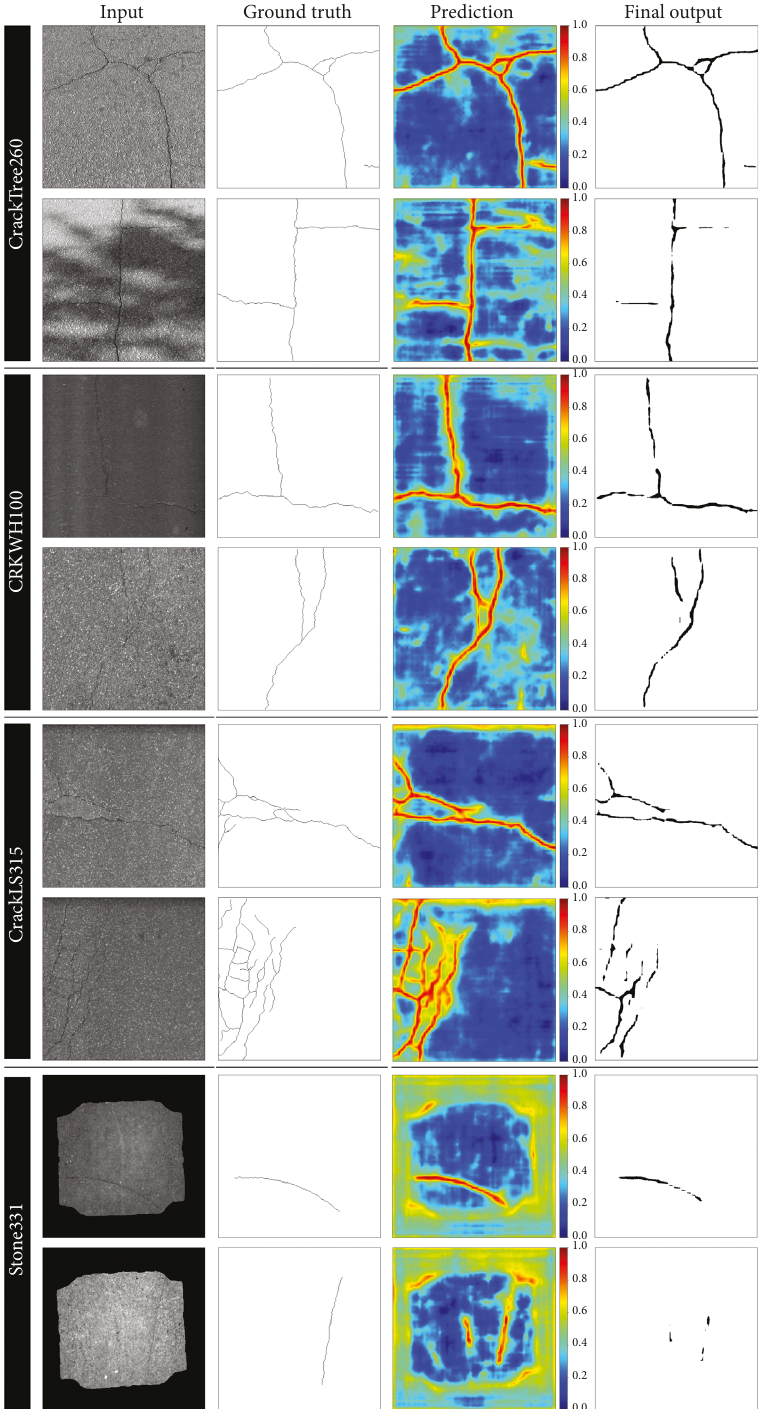
Figure 4: Some results from our downstream model that is trained by L images in the second and fourth columns are inverted and greyscale images in the third column are colorized with the jet colormap in